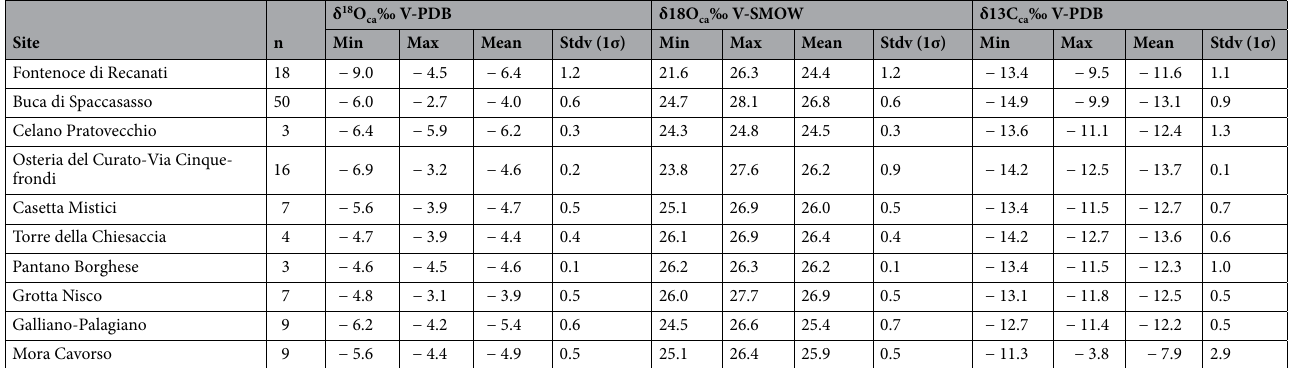
Table 2. Descriptive statistics for the investigated